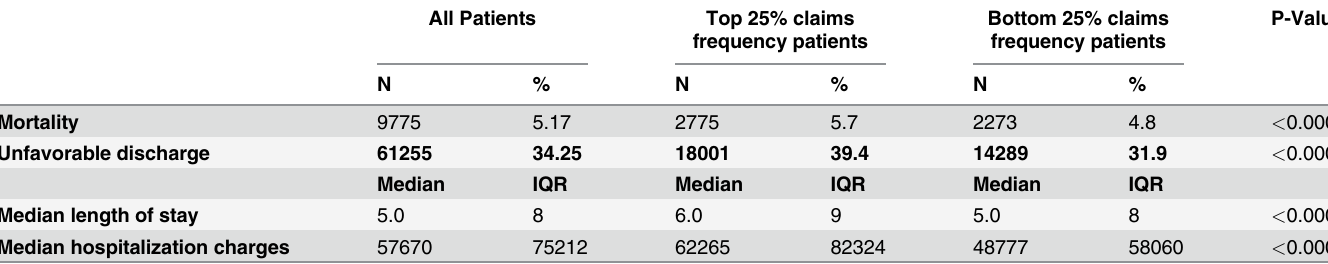
Table 2. Primary outcomes for patients undergoing cranial neurosurgical procedures in the United States.